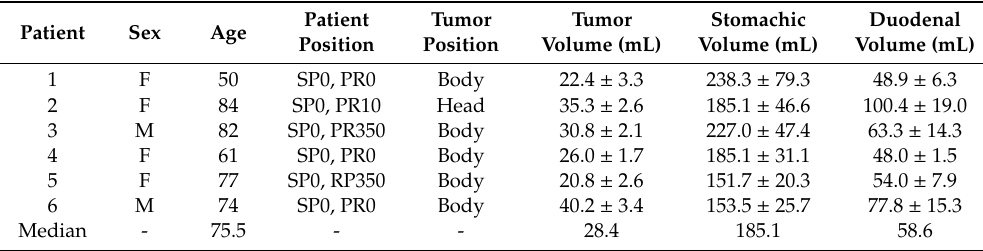
Table 2. Patient characteristics. Each volume is represented by the mean ± standard deviation of the 4 CT